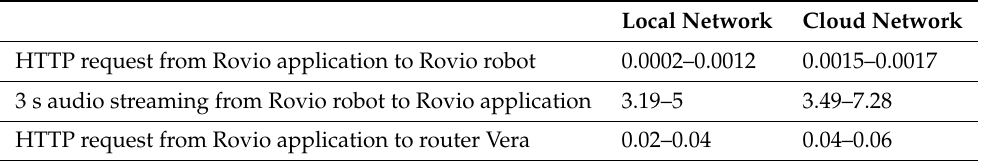
Table 1. Time response (in